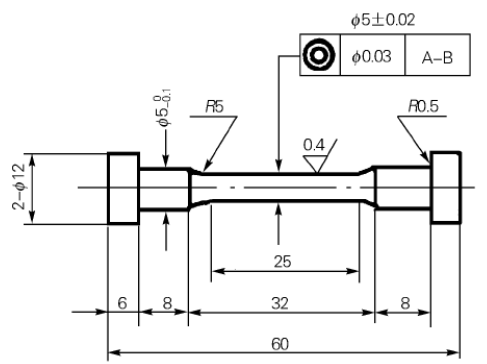
Figure 1. Shape and size of the stress rupture property specimen (mm).